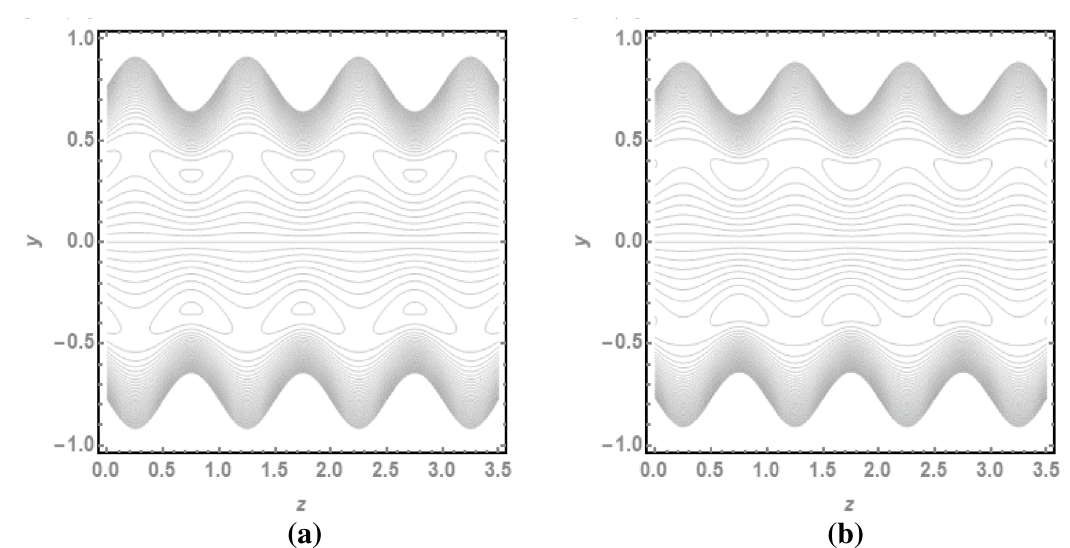
Figure 6. ( a ) Streamline for Q = 1.4 and σ > 0 . ( b ) Streamline for Q = 1.6 and σ > 0